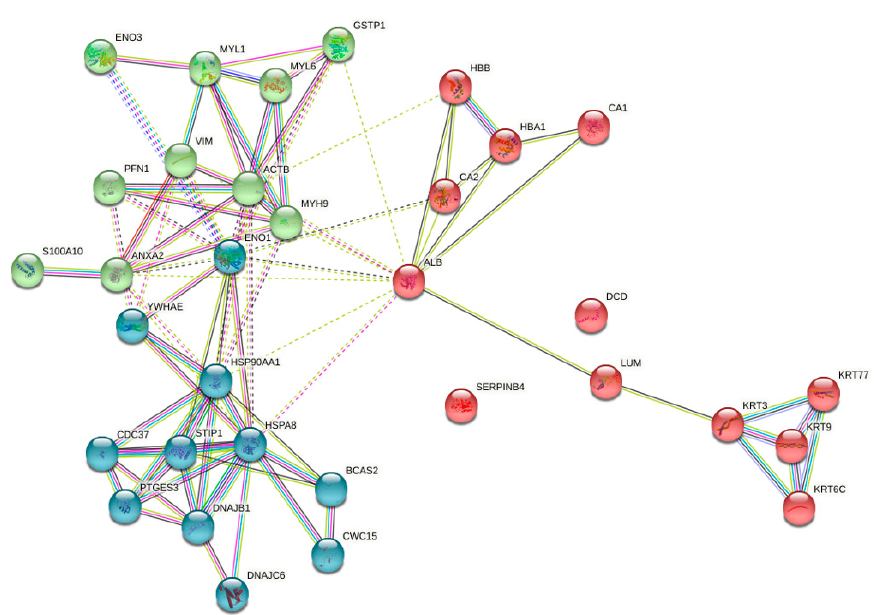
Figure 2. Representative 2DE gel images of normal, OSMF and OSCC tissue samples. 229